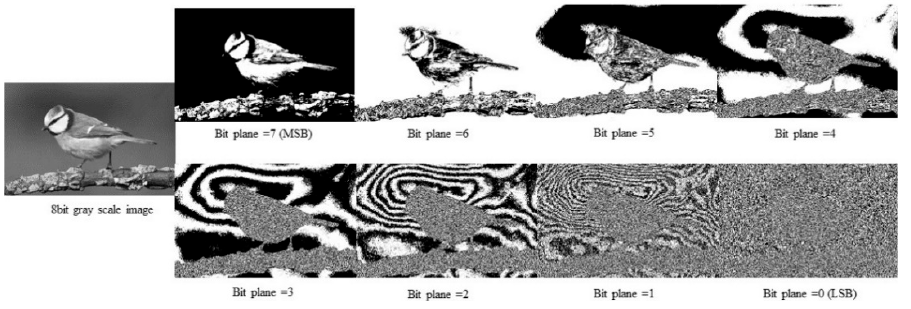
Figure 4. An 8-bit greyscale image’s bit